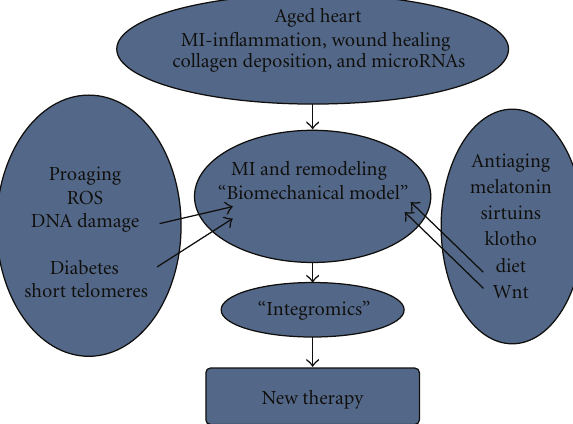
Figure 1: The possible interactions between Pro- and Antiaging factors is indicated. The proteins and their genes are well char- acterized but defined interactions in their signaling pathways and expression patterns during myocardial infarction and remodeling are not known. The knowledge of these interactions may help in further drug